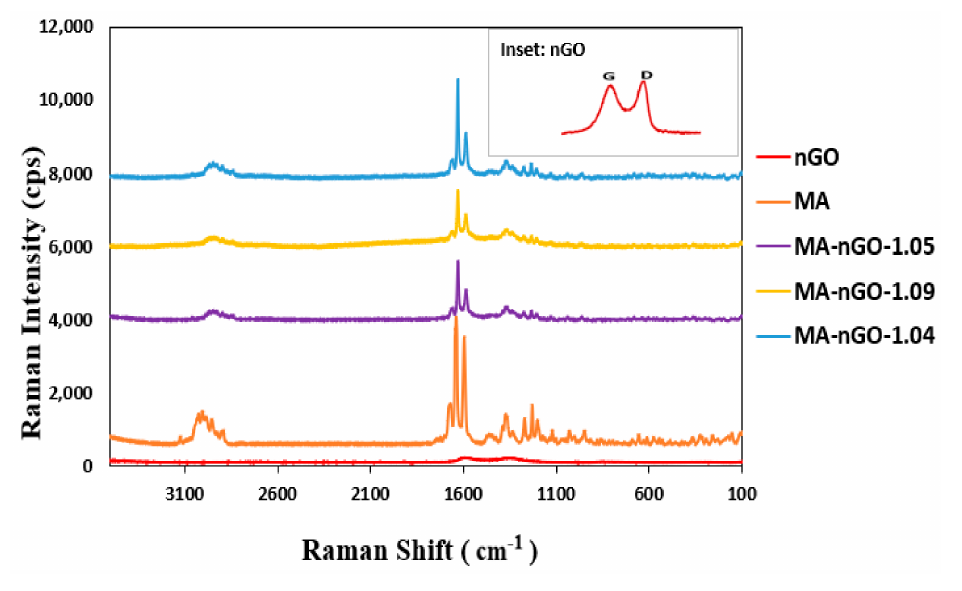
Figure 6. Raman spectra of pure MA and MA-nGO composites.